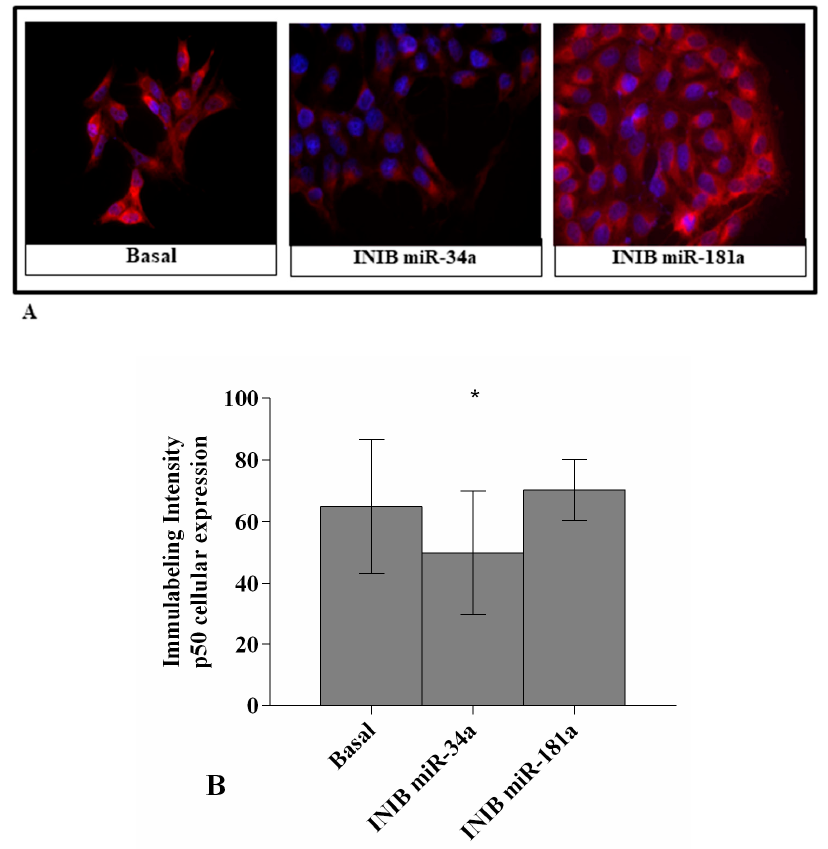
Figure 6. Immunofluorescence labelling of p50 NF- κ B subunit localization. Human osteoarthritic (OA) chondrocytes were evaluated at basal condition and after 24 h of transfection with miR-34a and miR-181a specific inhibitors (50 nM). ( A ) Representative immunocytochemical images of the cells showing localization of p50 NF- κ B (red); nuclei were stained with DAPI (blue). Original Magnification 400 × . Scale bar: 20 µ m. ( B ) The histogram of immunolabeling intensity was plotted for the nuclear and cytoplasm expression for p50 subunit. Data were expressed as mean ± SD of triplicate values. * p < 0.05 versus basal condition. INIB = Inhibitor.